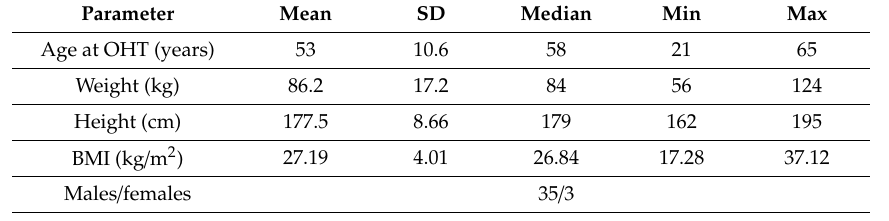
Table 1. Study cohort